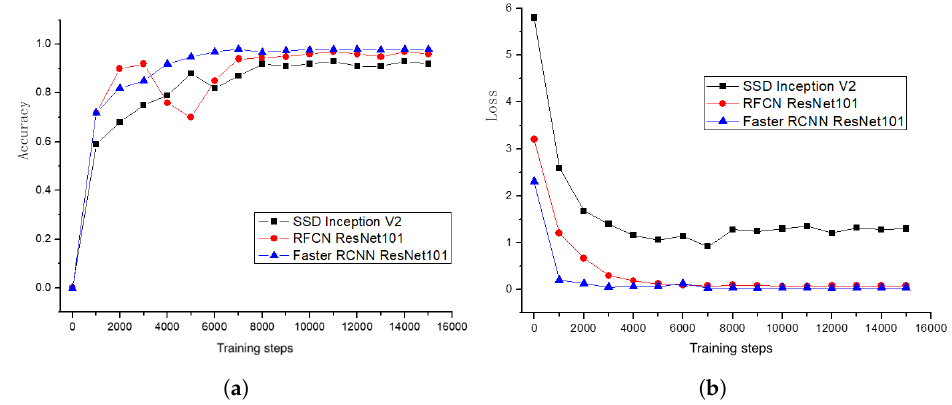
Figure 10. Results on the test set: ( a ) Accuracy vs. training steps. ( b ) Loss vs. training steps. We plot the confusion matrices of the three models in Figure 11, from which we obtain a better understanding about the correct predictions and misclassifications. Taking SSD Inception V2 (the left matrix) as an example, 188 out of 203 normal samples were correctly predicted, nine were misclassified as scratch, and six were misclassified as sprout. After checking, we found that these errors are caused by the mud, spot, or sprout eyes on the potato surface, which confused the model. Furthermore, 195 out of 210 scratch samples were correctly predicted, nine were predicted as normal, and six were predicted as sprout; an error analysis reveals that the potatoes with superficial scratches might be predicted as normal, and the ones with deep and large scratches could be predicted as sprout. As for the sprouted samples, 257 were correctly predicted, eight were misclassified as normal, and fourteen were predicted as scratch; our error analysis shows that the model tends to predict the potatoes with small sprouts or the ones with large but hidden sprouts due to camera shooting anger. RFCN ResNet101 presented the best performance, also reflected in the confusion matrix, in which only nine out of 693 potatoes were misclassified.